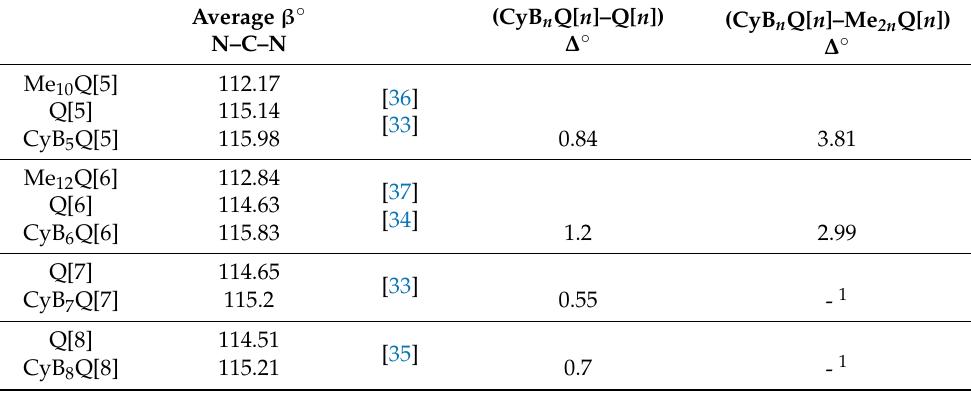
Table 3. A comparison of the β angle of the cis-fused junction of the glycoluril moieties of